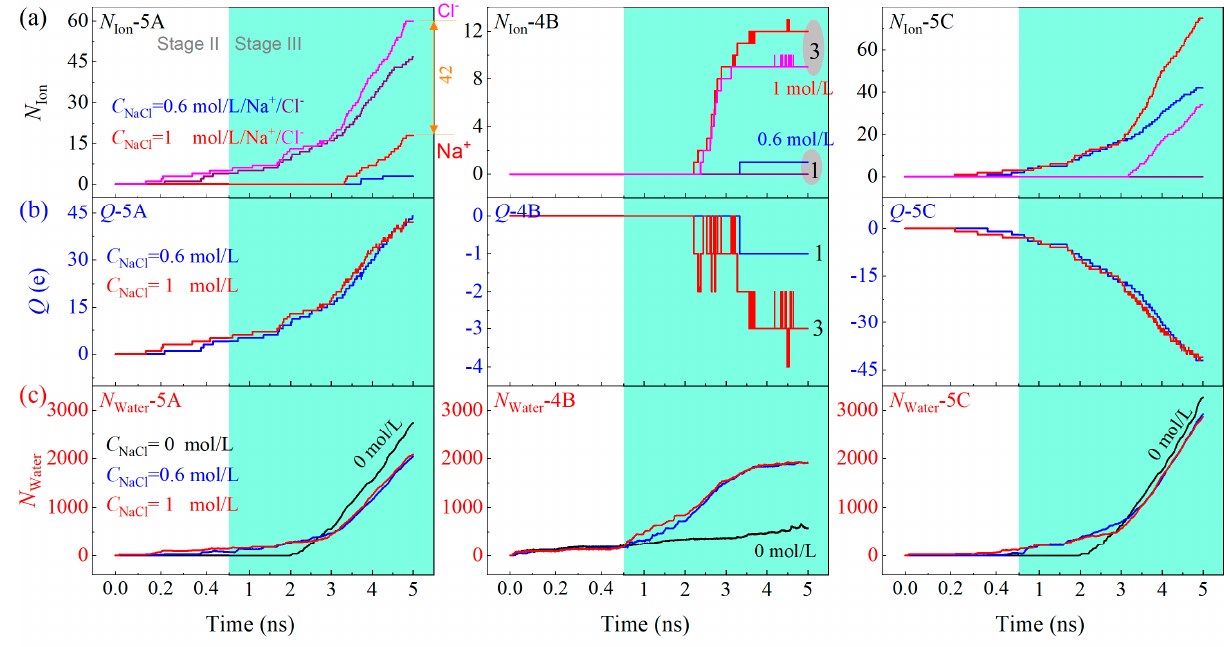
Figure 8. Physical quantities of the solution with different concentration flowing through the A-30 CTT nanochannel when E EF = 6.9 V/Å. ( a ) The number of ions in different containers, ( b ) the electric charges in the three containers, and ( c ) the number of water molecules via the three subchannels. When pure water ( C NaCl = 0) is in the resource reservoir, Ω 5A and Ω 5C have more water molecules than Ω 4B , which is due to the effective cross section for mass transfer of Ω 3B is smaller than those of Ω 3A and Ω 3C . However, when the concentration of solute is